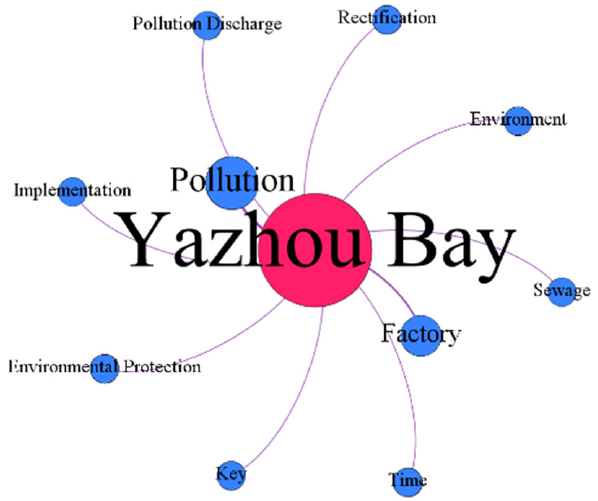
Figure 9. Construction of social semantic network related to Yazhou